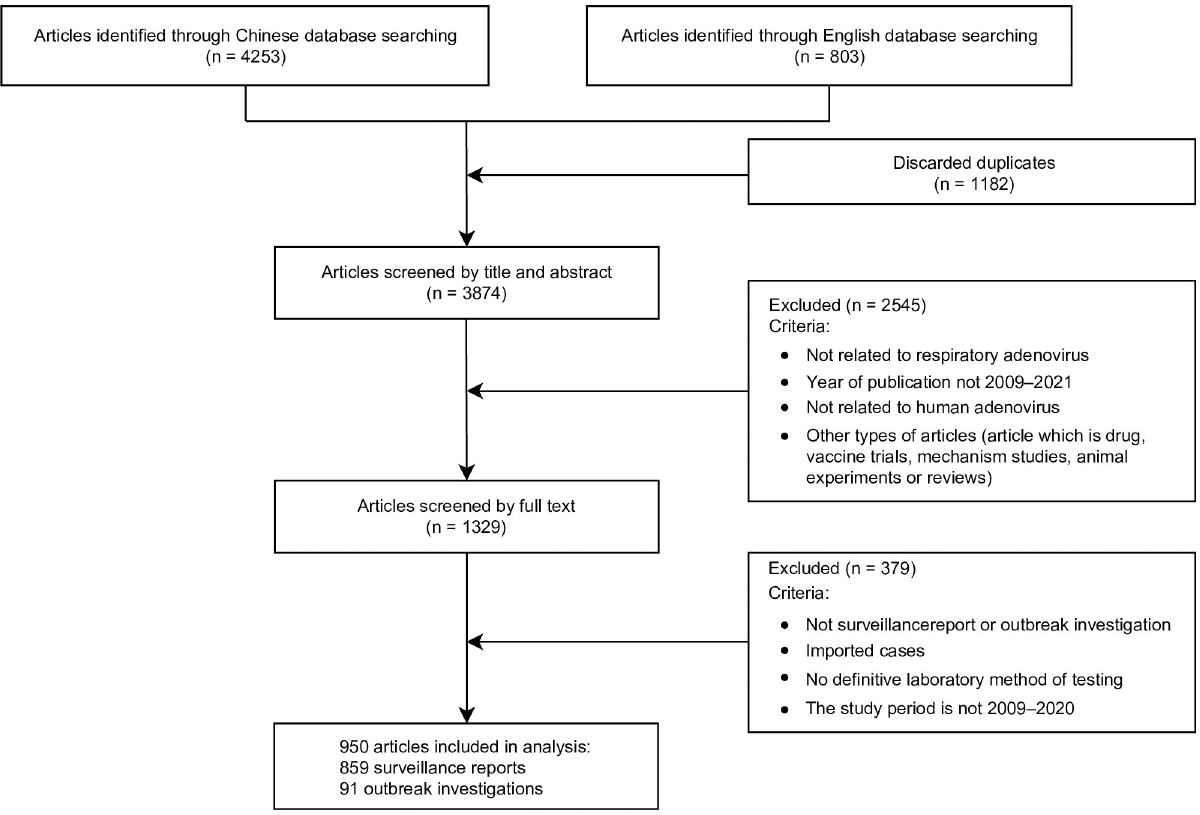
Fig 1. Flow diagram of the literature review. Literature search was performed from the major databases including the PubMed database (https:// pubmed.ncbi.nlm.nih.gov/), China National Knowledge Infrastructure (CNKI) (http://www.cnki.net/), Chongqing VIP Chinese Science and Technology Journal Database (CQVIP) (http://www.cqvip.com) and Wanfang databases (http://www.wanfangdata.com.cn/).